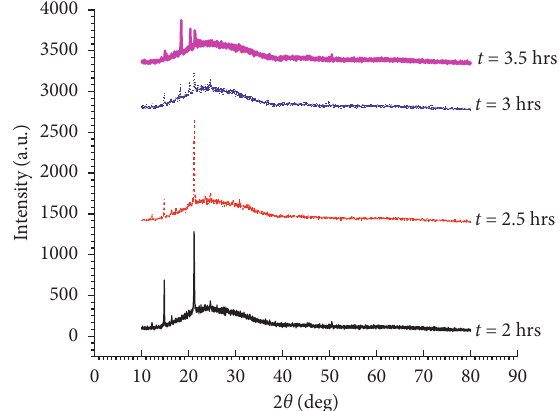
Figure 1: XRD pattern of cobalt sulfide thin films deposited at different deposition